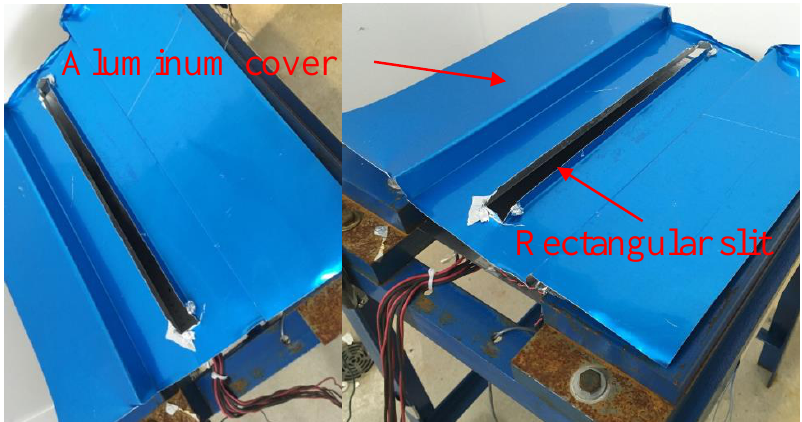
Figure 7. Aluminum cover for ice accumulation.